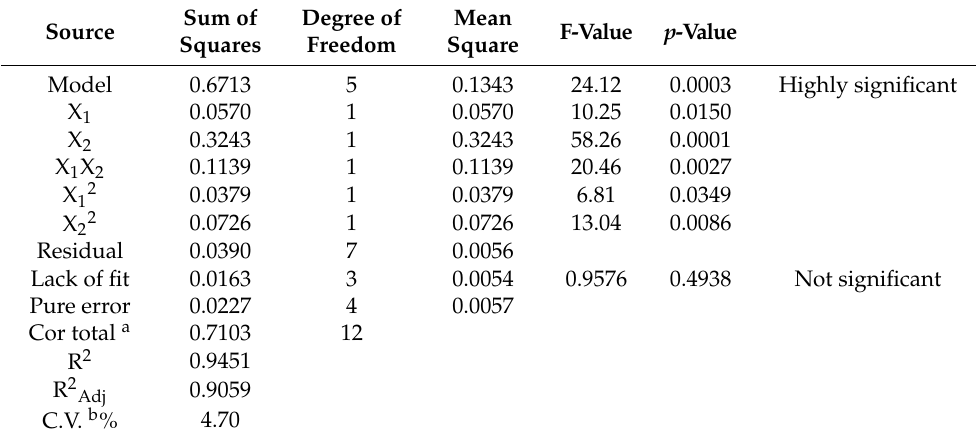
Table 2. Analysis of variance (ANOVA) for the experimental results in the optimization